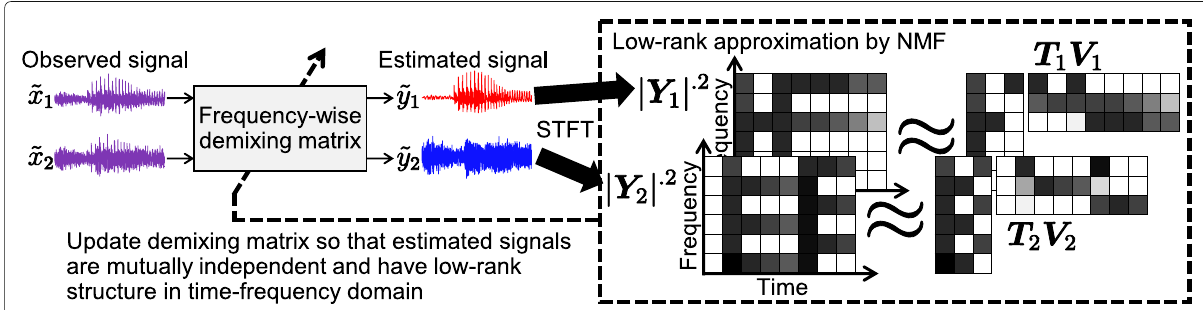
Fig. 3 Principle of source separation based on ILRMA. ILRMA assumes both statistical independence between sources and the low-rankness of time-frequency structures in each source